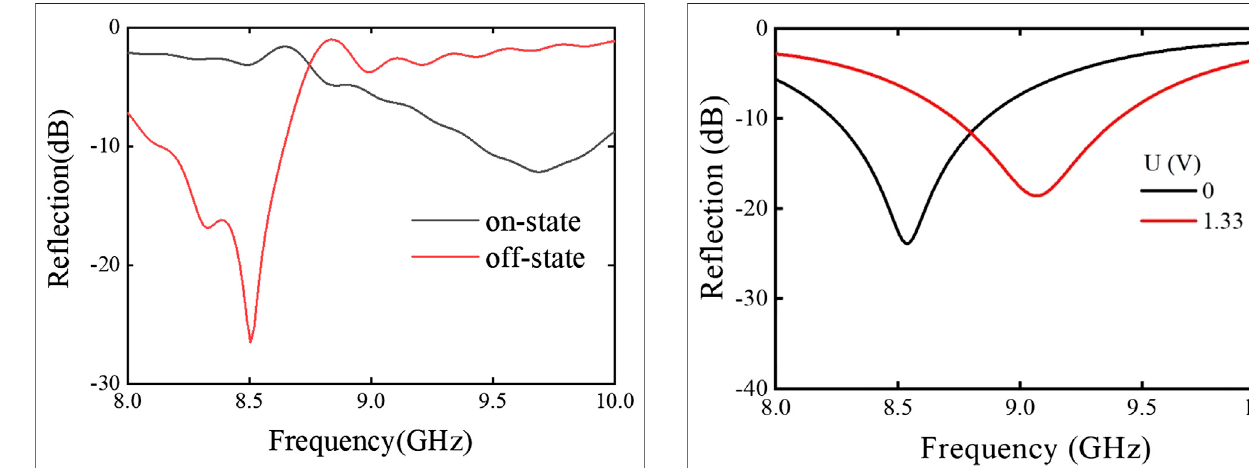
FIGURE 5 | The measured re fl ection spectra of the active high impedance metasurface when the PIN diodes are loaded with +1.33 V bias voltage (red line) and in open-circuit state (black